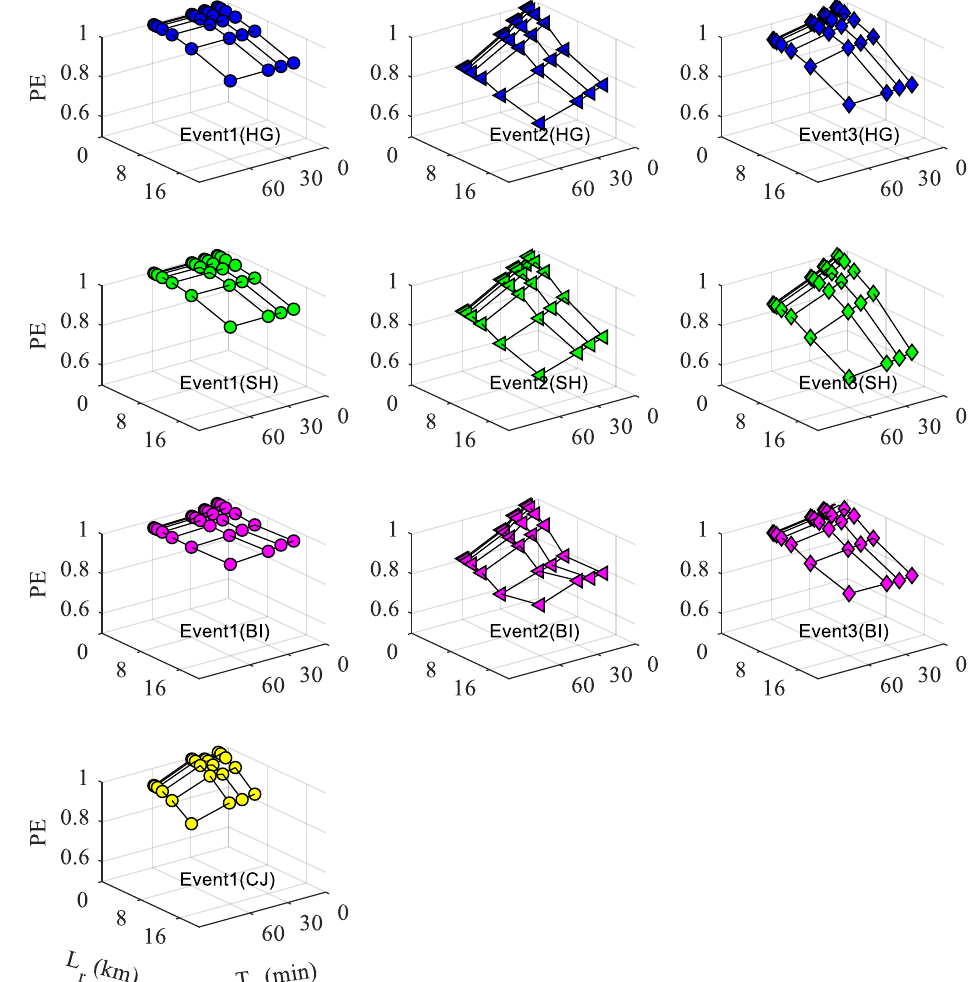
Figure 6. PE values for runoff predictions with various RSRs and RTRs.